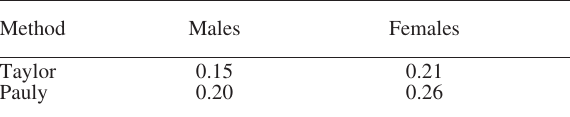
Table 4. – estimated natural mortality rates for male and female H. didactylus sampled in the Bay of Cádiz between March 1999 and March 2000